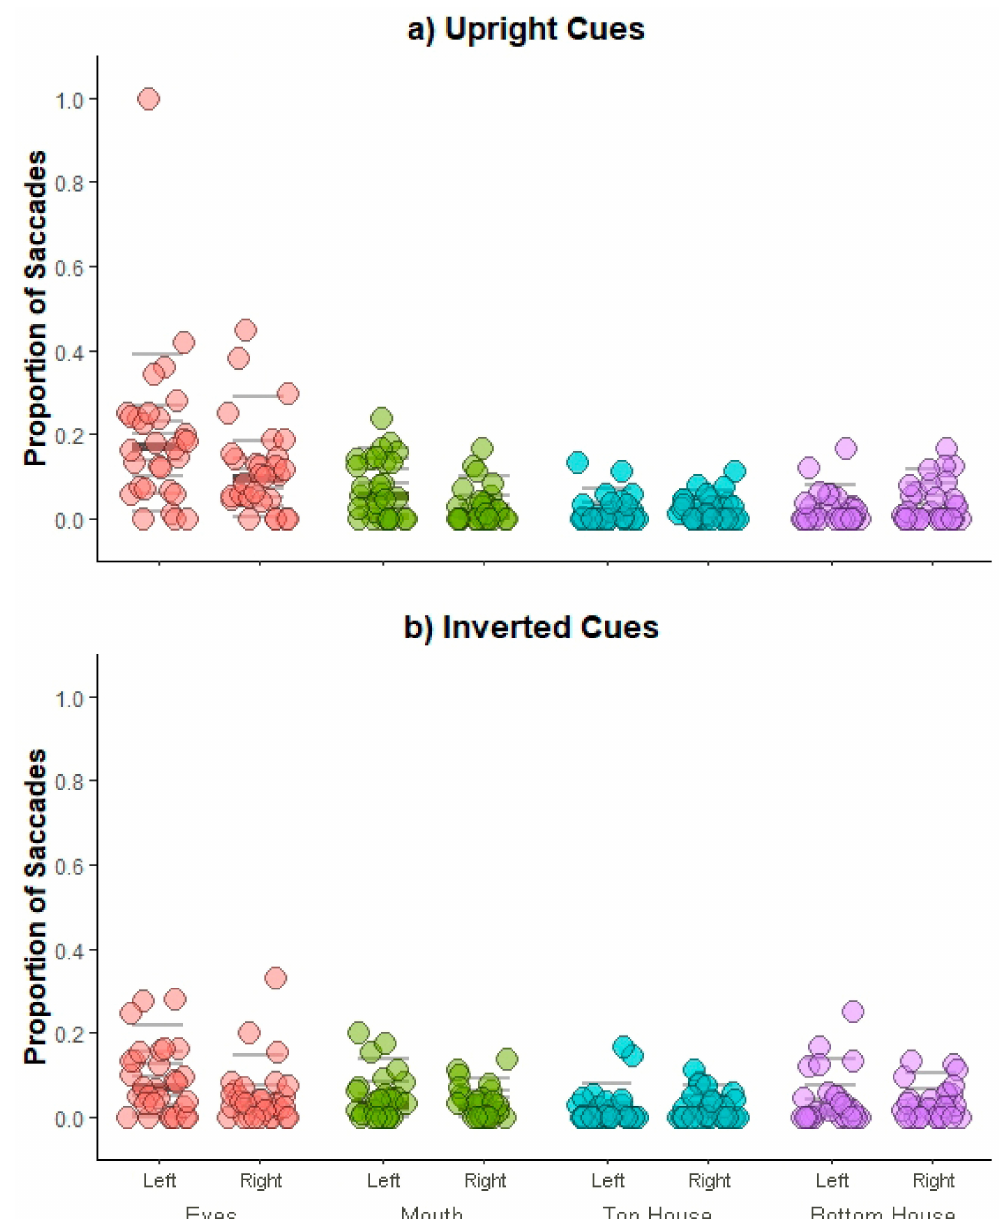
Figure 6. Experiment 2 eye movement results. Stripcharts depicting mean proportion of saccades for each participant during the cue presentation period as a function of face position and ROI for Upright ( a ) and Inverted ( b ) cues. Horizontal lines mark the deciles, with the thicker darker line representing the median. Note that the pattern of results does not change even if the outlier is removed from analyses. Similar to the overall comparisons, there were main e ff ects of Cue orientation [ F (1,29) = 13.23, p = 0.001, η p2 = 0.31] and Face position [ F (1,29) = 9.90, p = 0.004, η p2 = 0.25], showing that a greater proportion of saccades occurred when cues were upright and when faces were presented in the left visual field, respectively. Importantly, we also found a main e ff ect of ROI [Mauchly’s test of sphericity, χ 2 (5) = 25.89, p < 0.001; F (1.92,55.54) = 43.53, p < 0.001, η p2 = 0.60], with an overall greater proportion of saccades towards the eyes compared to all other ROIs [ t s > 6.79, p s < 0.001, d z s > 1.24] and an overall great proportion of saccades towards the mouth compared to top house [ t (29) = 4.06, p = 0.001, d z = 0.74; all other p s > 0.07, d z s <